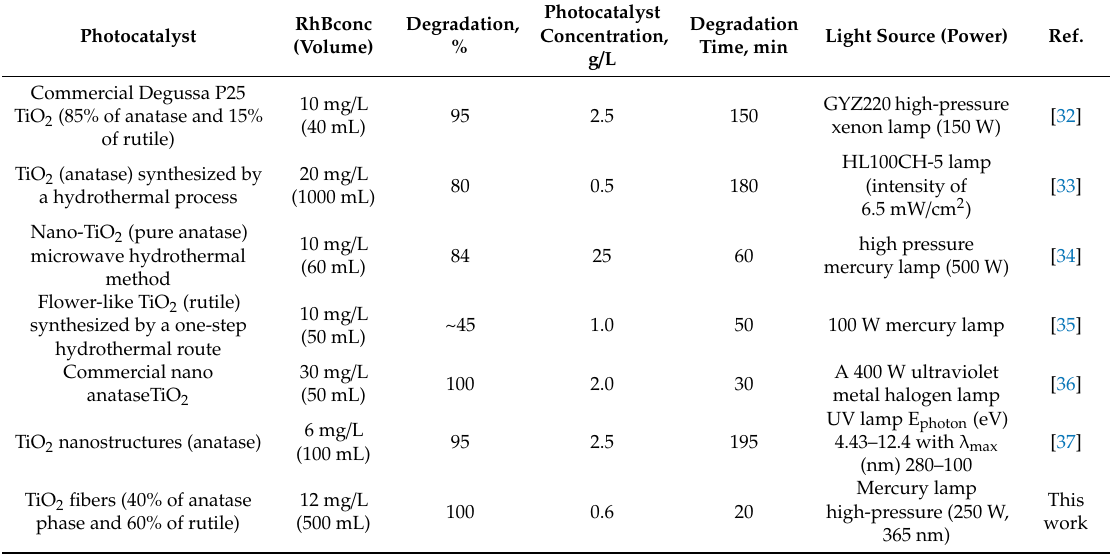
Table 4. Comparison of the photocatalytic activity of TiO 2